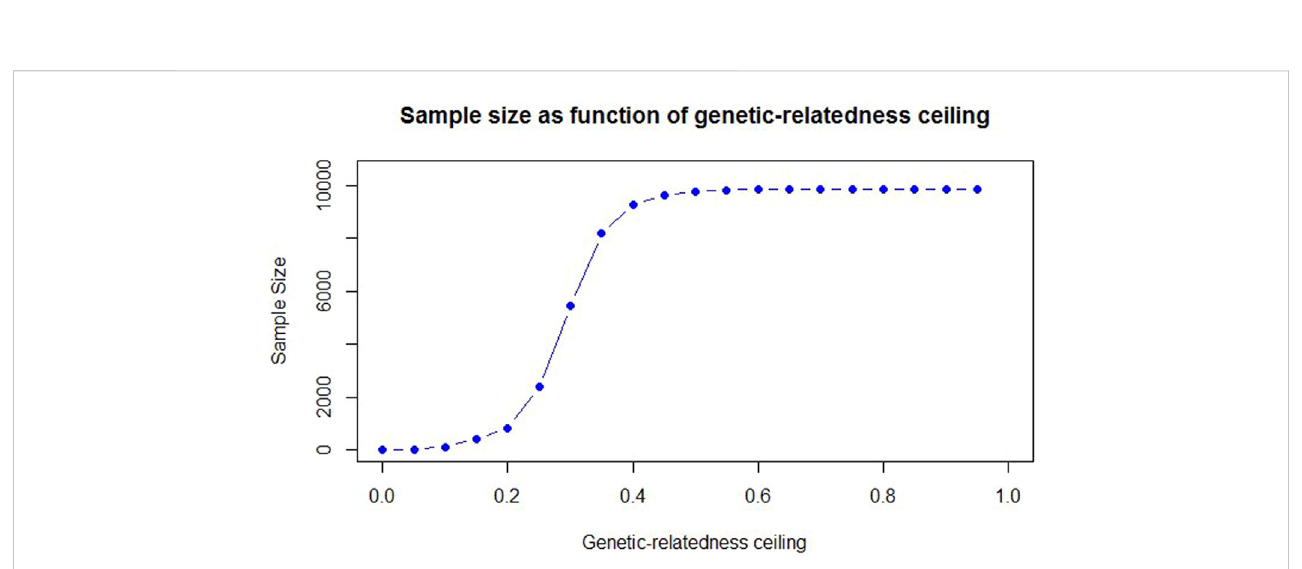
FIGURE 2 The change of sample size by applying the degrees of genetic-relatedness